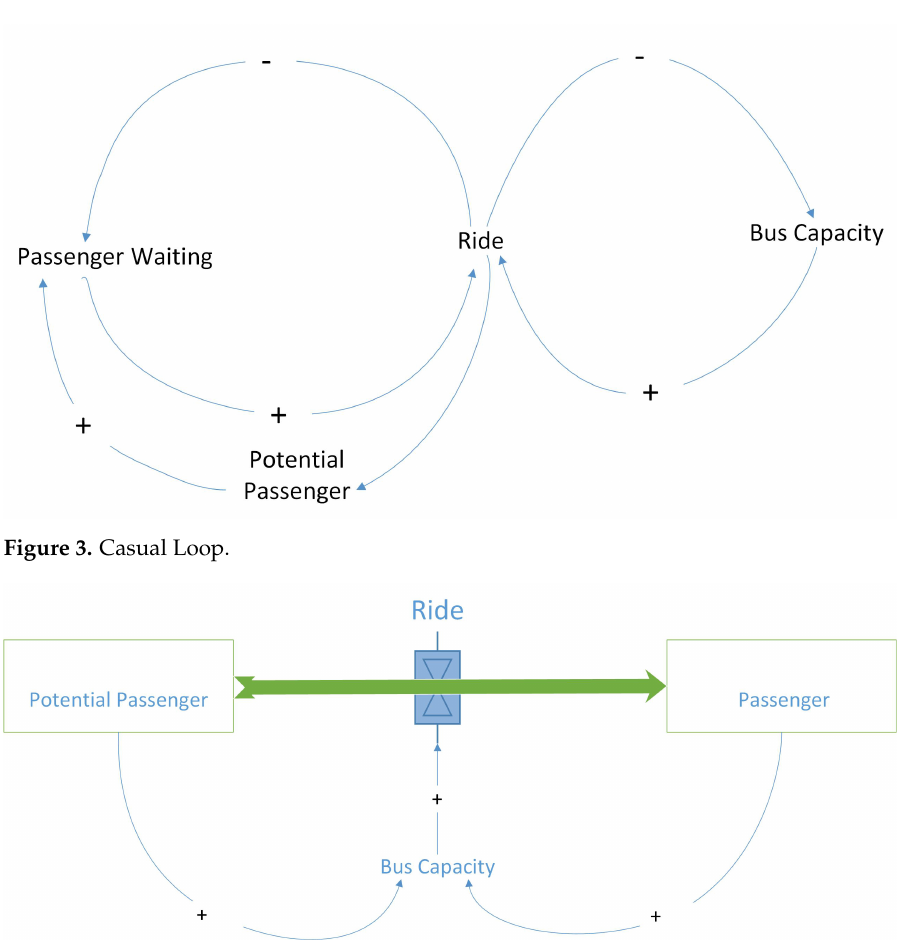
Figure 4. Stock and Flow